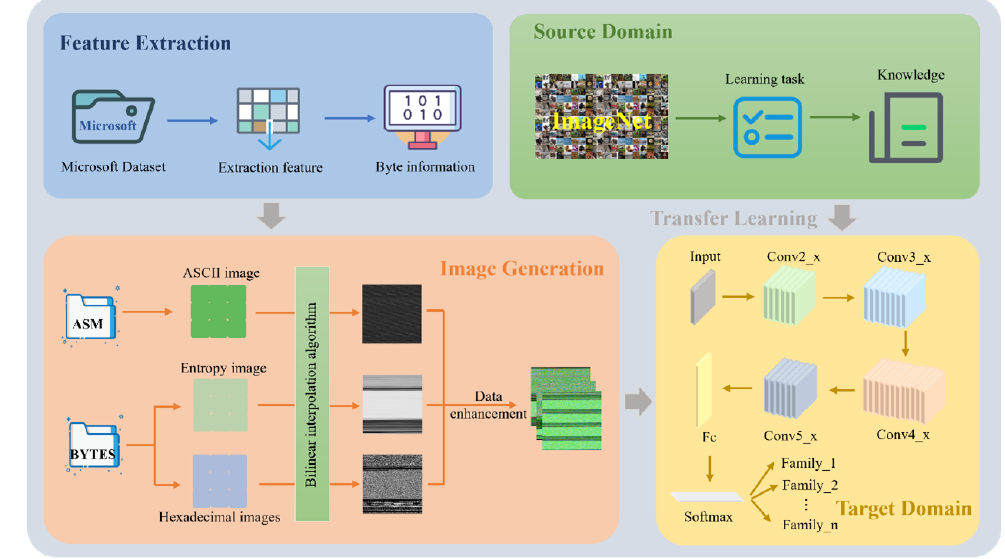
Figure 1. The proposed program